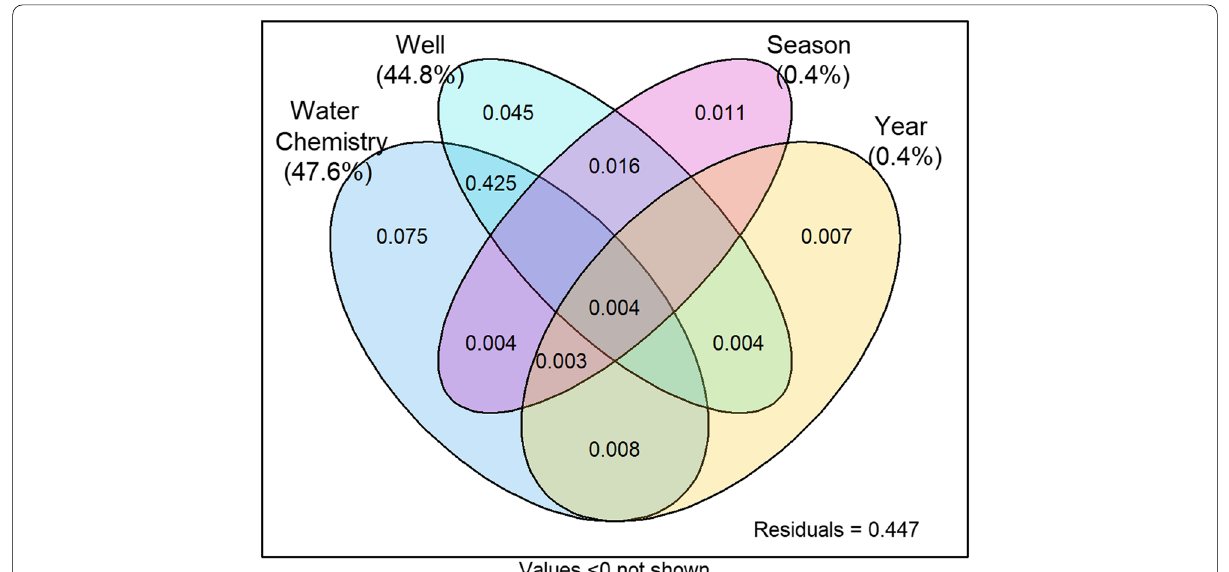
Fig. 3 Variation partitioning of proportions of variation in microbial community composition explained by water chemistry, year, season, and well. Values in parentheses indicate the variances explained by the respective variables but without removing the contribution from